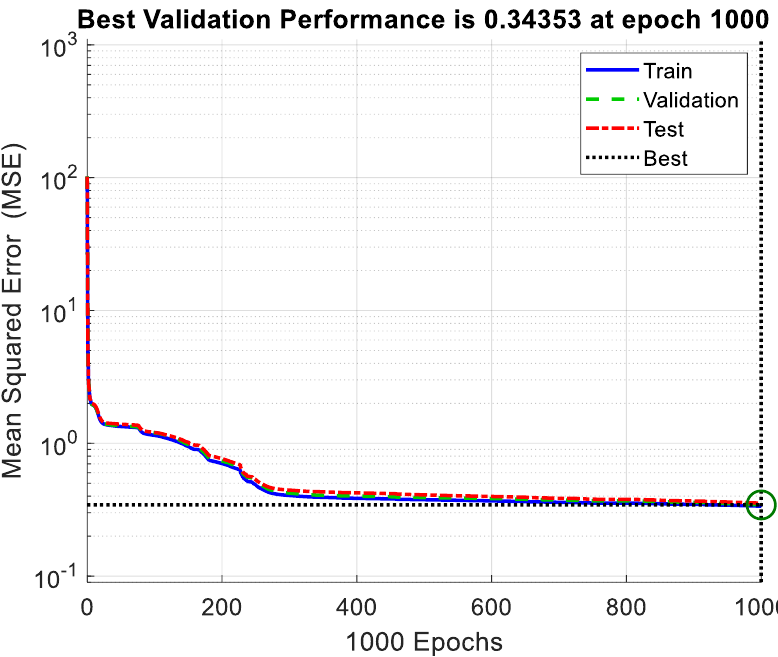
Figure 6. The resulting MSE through the training process of the designed NARXNN architecture.